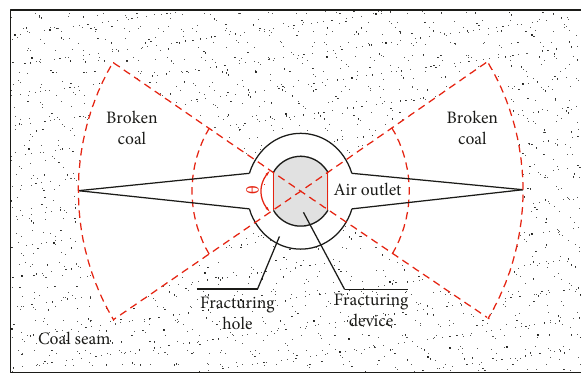
Figure 7: Schematic diagram of CO